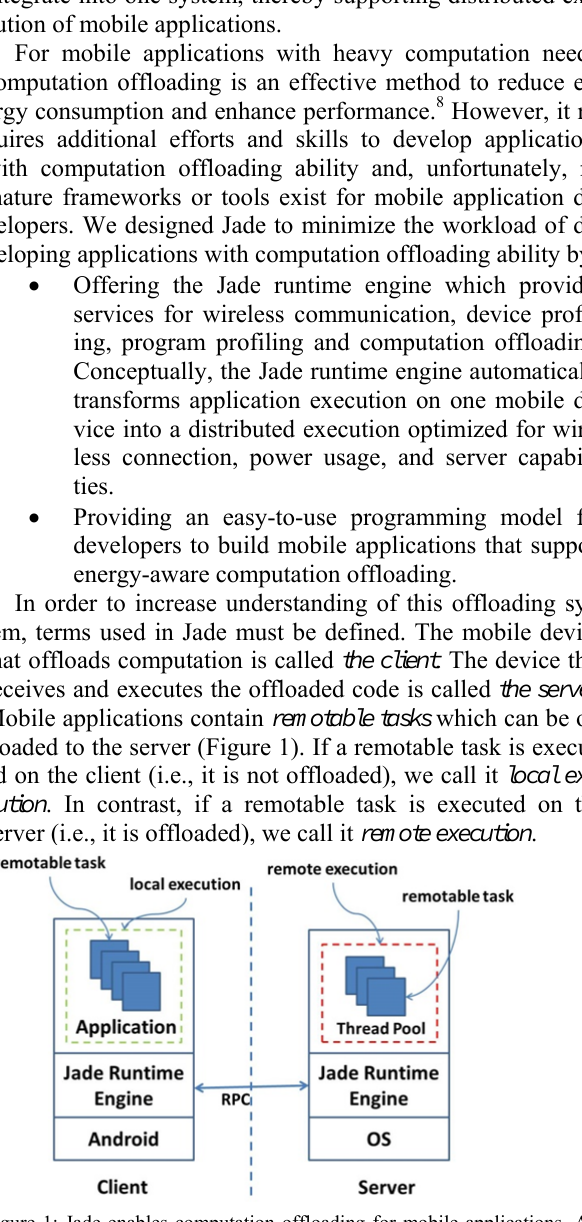
Figure 1: Jade enables computation offloading for mobile applications. Ap- plications contain remotable tasks that can be offloaded from the client to the server. Jade runtime engine automatically decides where to execute remotable tasks and initiates distributed execution.